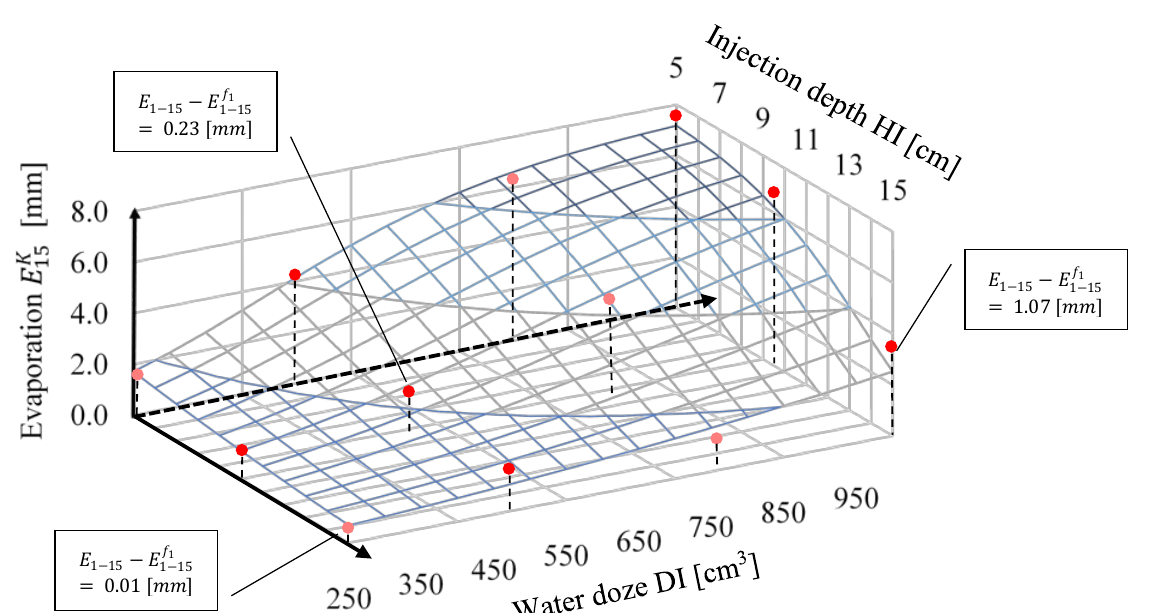
Figure 7. Function of evaporation (after 15 days) in relation to injection depth (HI cm) and water dose (DI cm 3 ): ( DI , HI ) E f 1 1 − 15 .